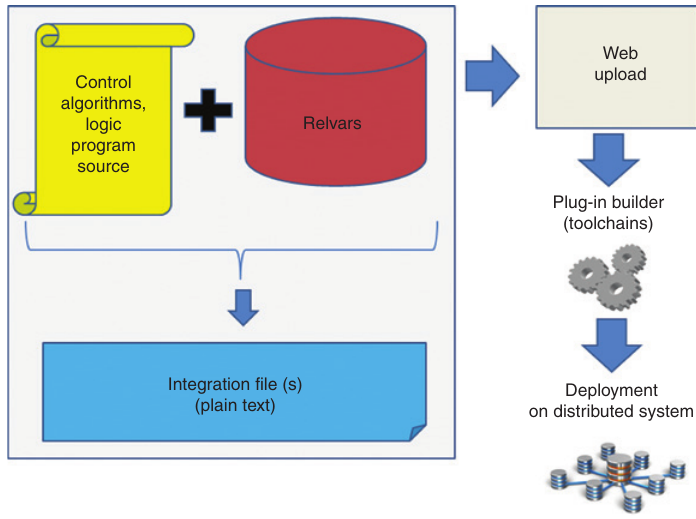
Figure 3: Plug-In Design and Deployment